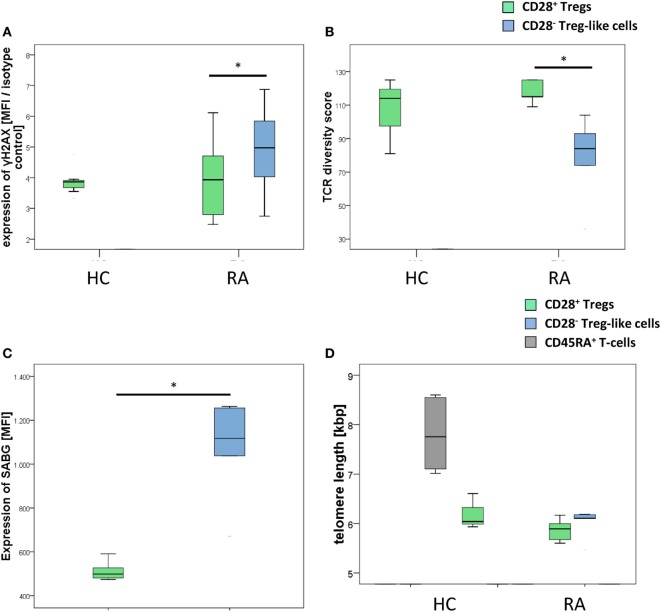
CD28− regulatory T-cells (Tregs)-like cells show evidence of advanced replicative senescence. Graphs show (A) expression of γH2AX, (B) T-cell receptor diversity, (C) expression of senescence-associated β-galactosidase (SABG), and (D) telomere lengths of CD28+ Tregs (green), CD28− Treg-like cells (blue), and naive CD45RA+ T-cells (gray). Mann–Whitney U test was used to assess differences between groups. *p < 0.05; n = 5.